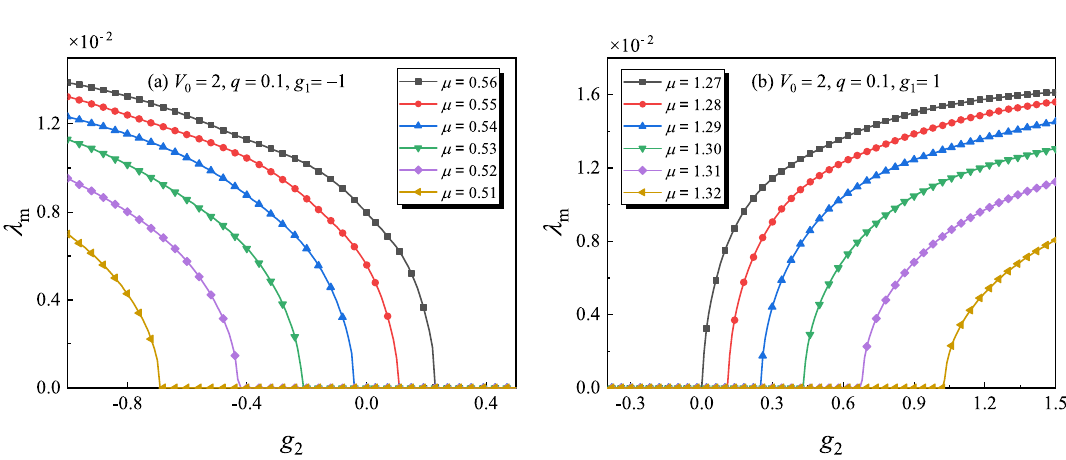
Figure 8. Maximum growth rate of perturbation (cid:31) m for the gap solitons versus the three-body interaction strength g 2 under different chemical potential µ . The profiles of gap solitons are similar as Fig. 7b or d. ( a ) In the semi-infinite gap. ( b ) In the first